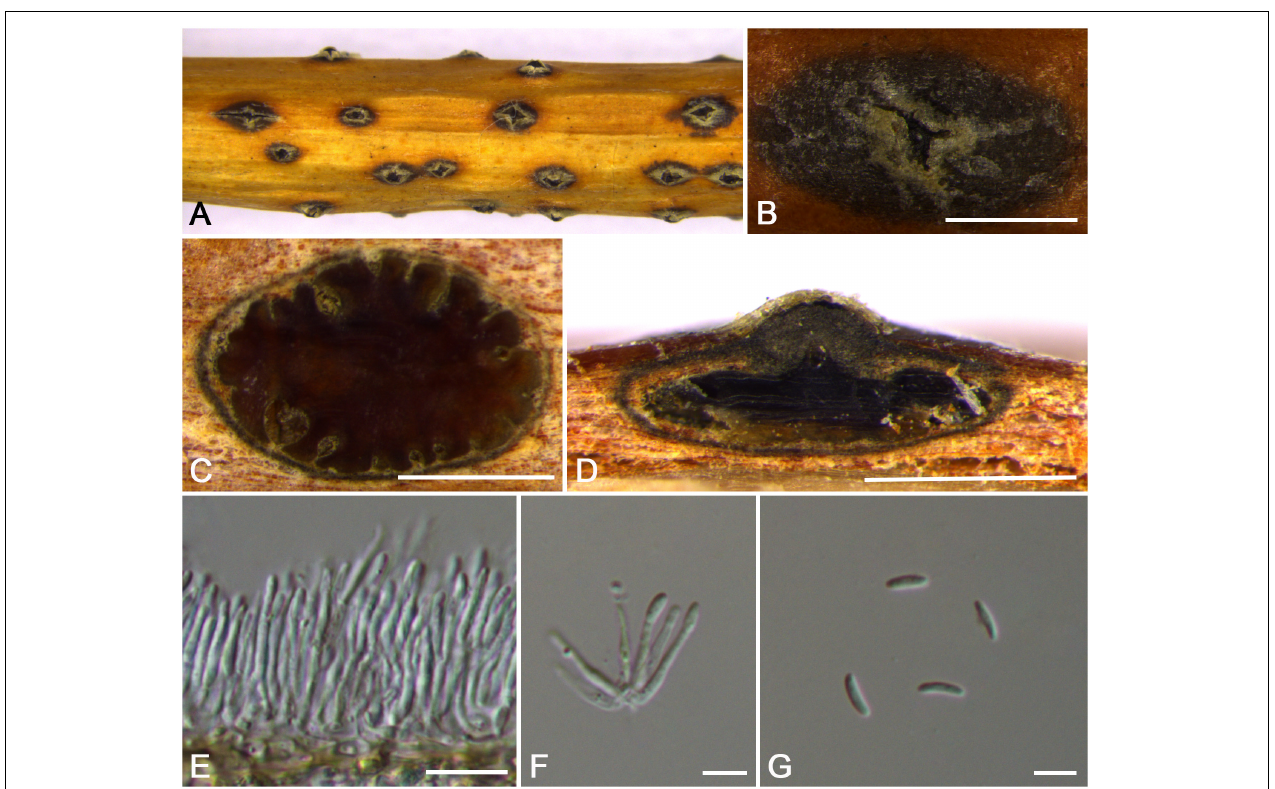
FIGURE 12 | Morphology of Cytospora sorbina from Sorbus tianschanica (CF 20197660). (A,B) Habit of conidiomata on twig. (C) Transverse section of conidioma. (D) Longitudinal section through conidioma. (E) Conidiophores and conidiogenous cells. (F,G) Conidia. Bars: (B–D) = 500 µ m; (E) = 10 µ m; (F,G) = 5 µ m.